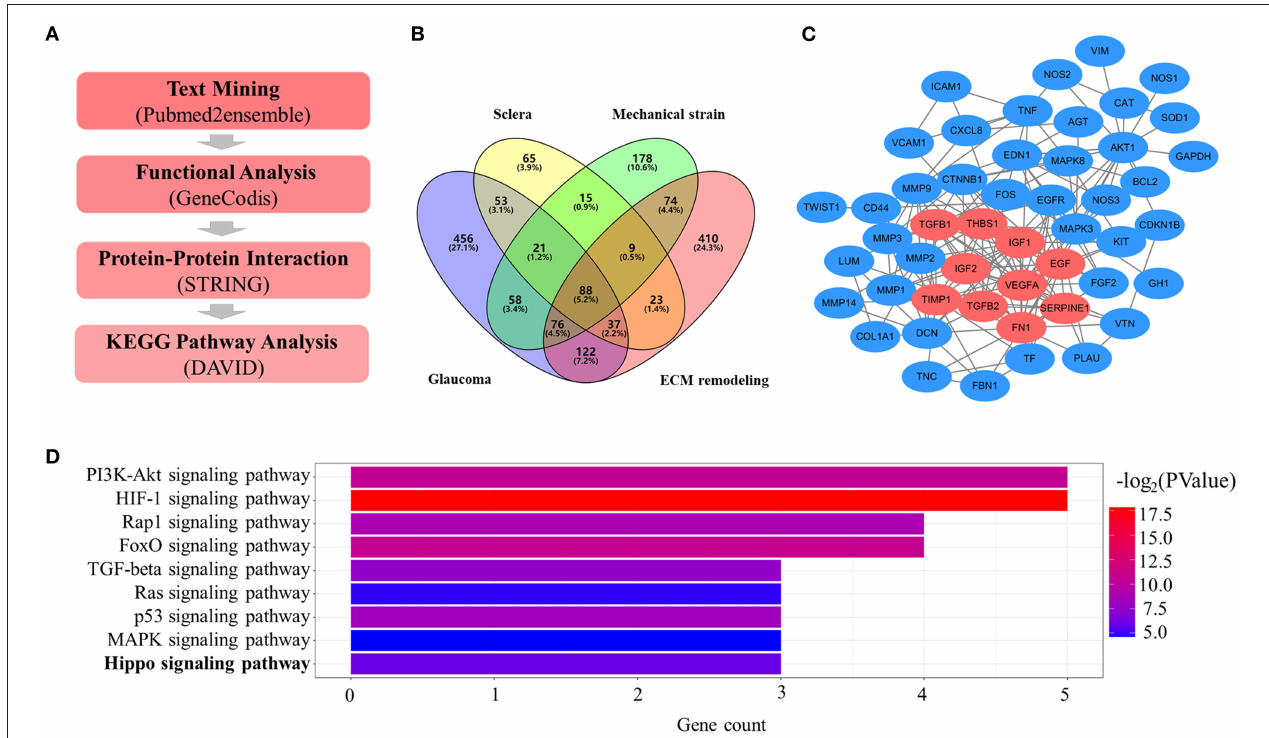
FIGURE 1 | Key signaling pathway in mechanical strain-induced scleral ECM remodeling in glaucoma. (A) Overall bioinformatics analysis strategy. (B) Venn diagram of the text mining genes related to glaucoma, sclera, mechanical strain, and EMC remodeling. The 88 common genes were considered to be related to mechanical strain-induced scleral ECM remodeling in glaucoma. (C) The protein-protein interaction (PPI) network of the 54 target text mining genes, red circles represent the significant module genes. (D) Significantly enriched KEGG signaling pathways in gene module. Abbreviations: EMC, extracellular matrix; KEGG, Kyoto Encyclopedia of Genes and